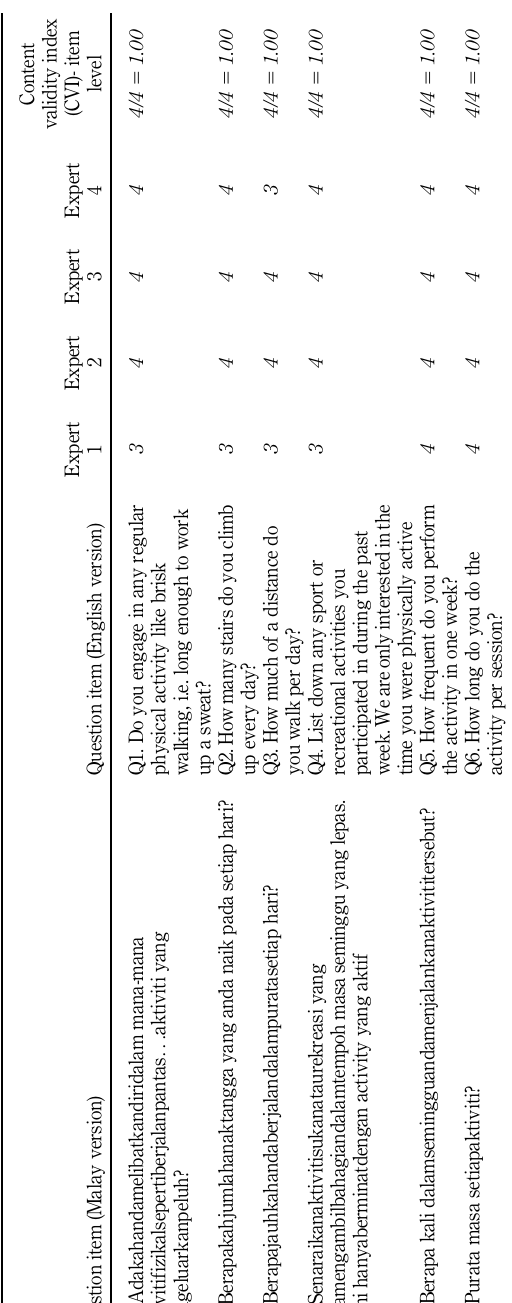
Table 1. Content validity index of Malay version